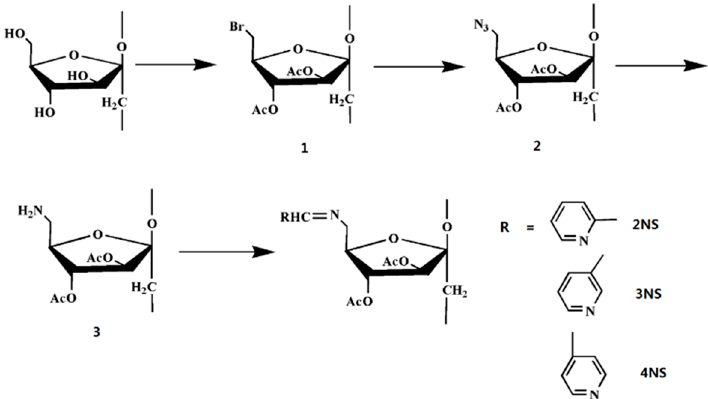
Scheme 1. Synthetic pathway for Schiff bases of inulin. Table 1. Yields and the degrees of substitution of the inulin derivatives.